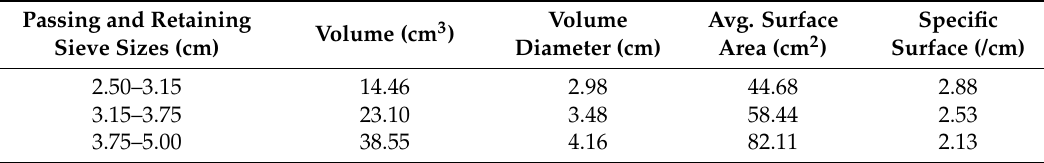
Table 1. Properties of the porous media